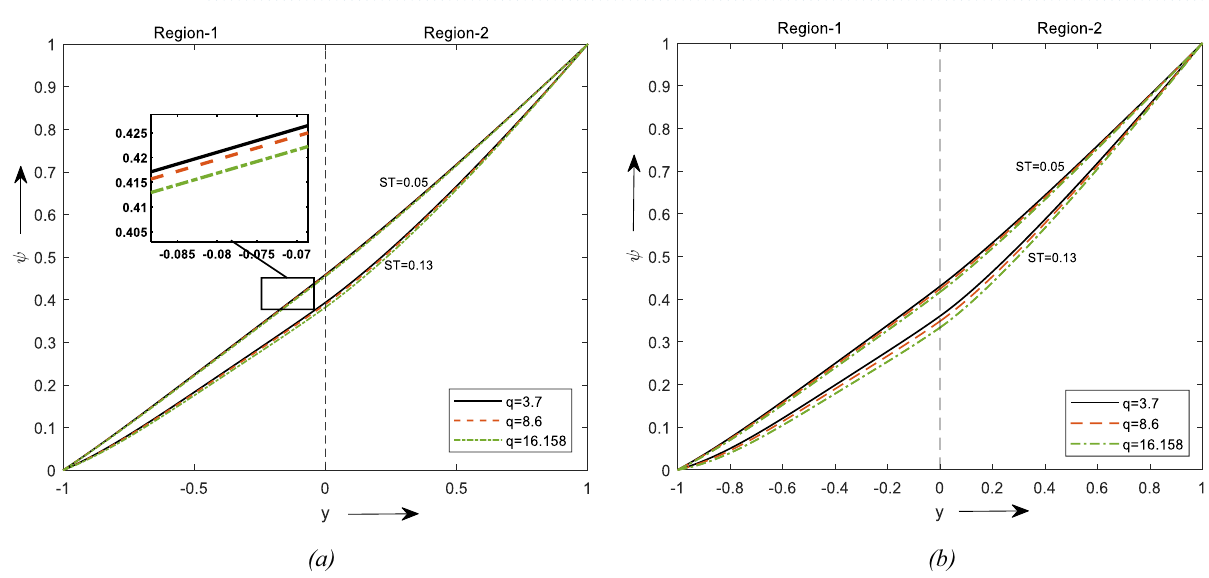
Figure 7. Concentration profiles for different values of ST. ( a ) For two different values of φ . ( b ) For a value of φ